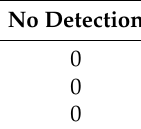
Table 1. Basis for testing urine and stool. Stool Urine Stool and Urine No Detection Temperature ( ◦